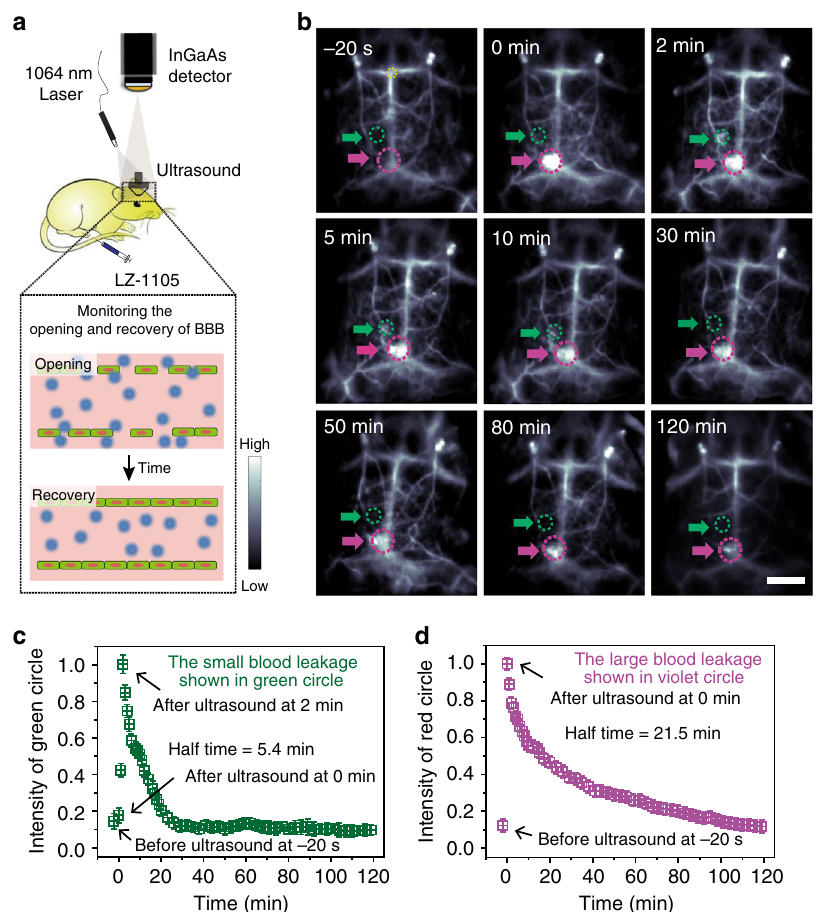
Fig. 5 Real-time noninvasive NIR-II imaging to monitor the opening and recovery of the blood – brain barrier (BBB). a Schematic illustration of the NIR-II imaging setup to monitor the opening and recovery of the BBB. b The NIR-II images of the mice brain before and after treated with focused ultrasound (FUS) and microbubbles at different time points ( n = 3 mice). The green and violet circles and arrows indicate the opening and recovering points of cerebral vessels. Corresponding normalized mean signal intensity of green ( c ) and violet a ( d ) circles as a function of time. The fl uorescence intensity region (noted as the yellow circle) of each images was normalized to measure the signal intensity decreasing process of the leakage on the brain vessels. Data point with its error bar stands for mean ± s.d. derived from n = 3 replicated measurements. Scale bar represents 4 mm. Source data underlying c and d are provided as a Source Data fi